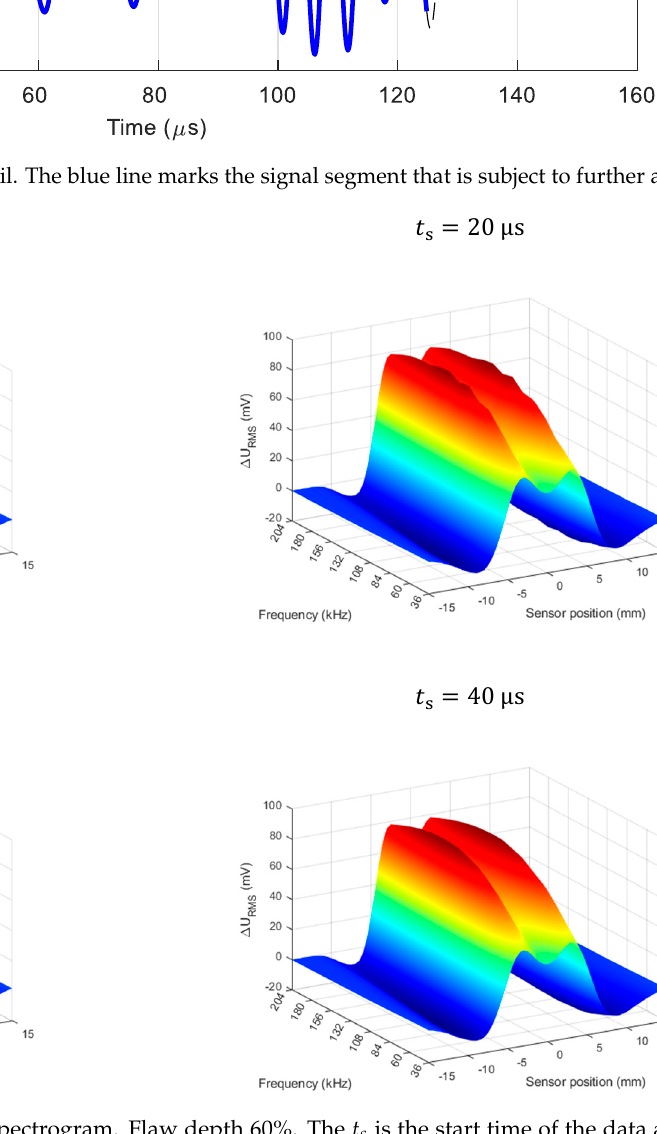
Figure 5. The measured signal on the pickup coil. The blue line marks the signal segment that is subject to further analysis.